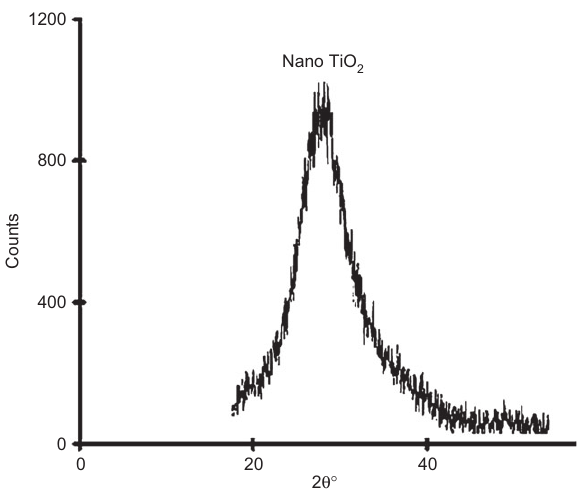
Figure 2 XRD spectrum of TiO